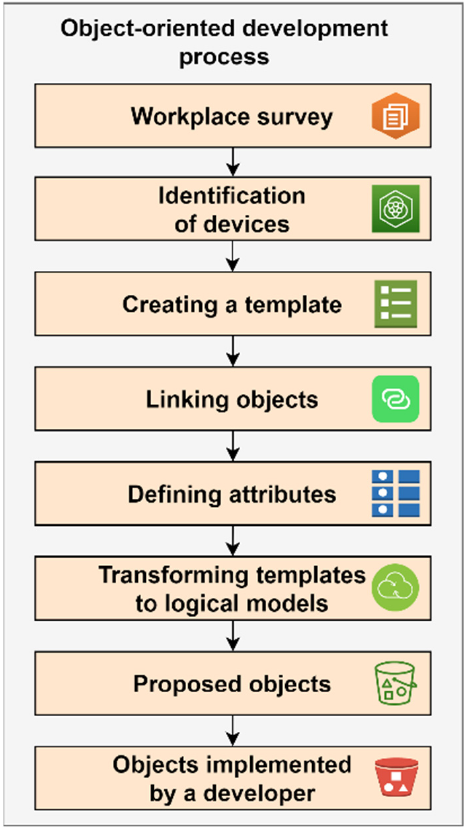
Figure 2. Object-oriented integration